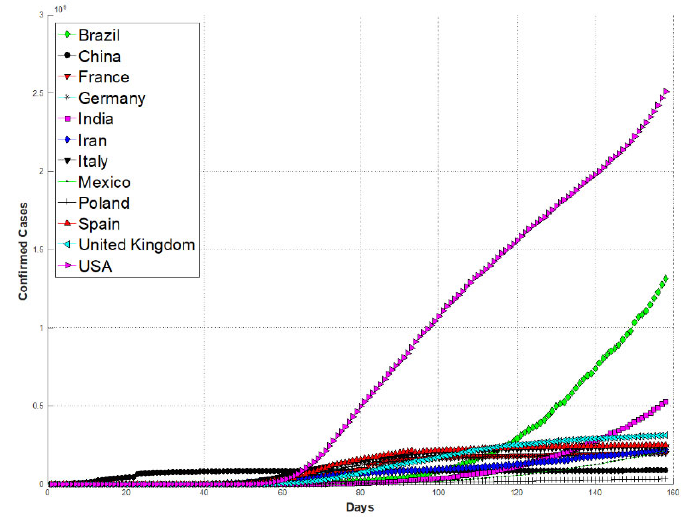
Figure 10. Second data period.